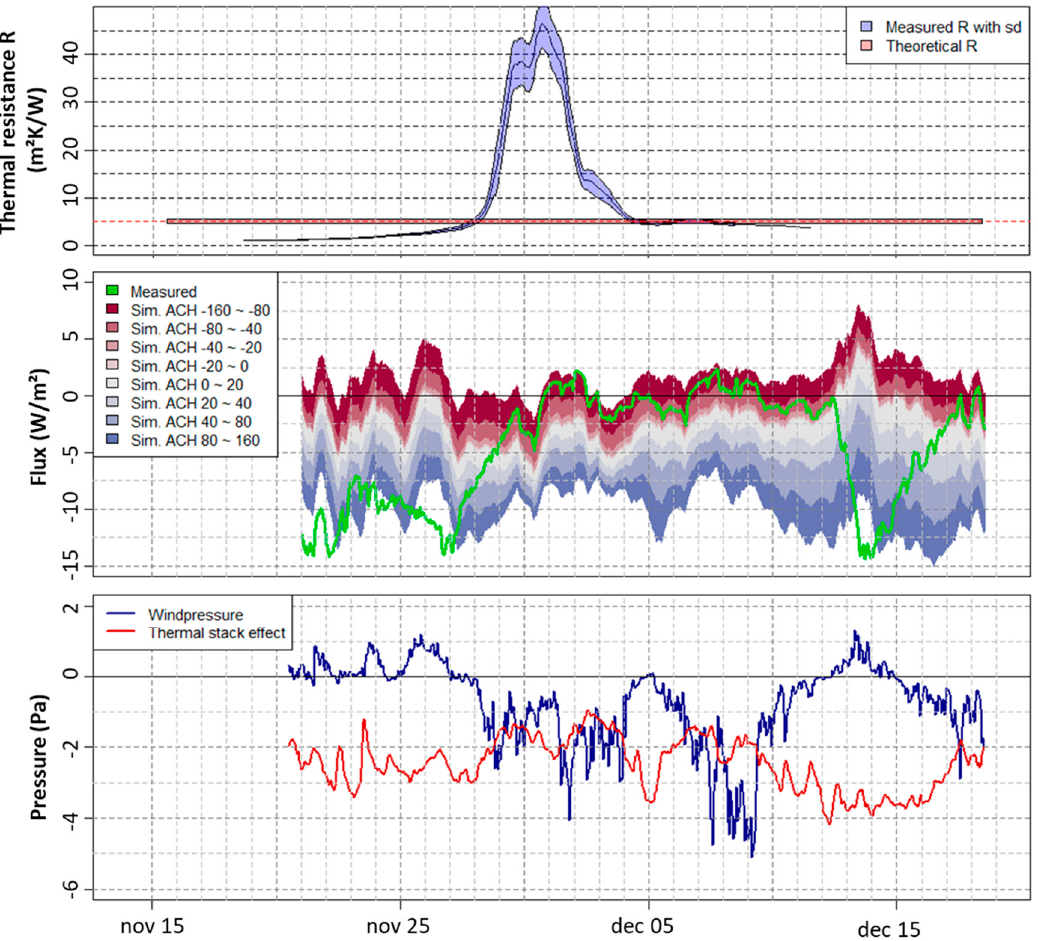
Figure 9. Assessment of the measured thermal resistance and heat flux for measurement location 7. Top: Estimated thermal resistance for a moving window of 10 days along the dataset, each time shifting with 1 h. Middle: Simulated heat fluxes vs. measured heat flux. Bottom: Simulated wind pressure and thermal stack pressure on the front facade.